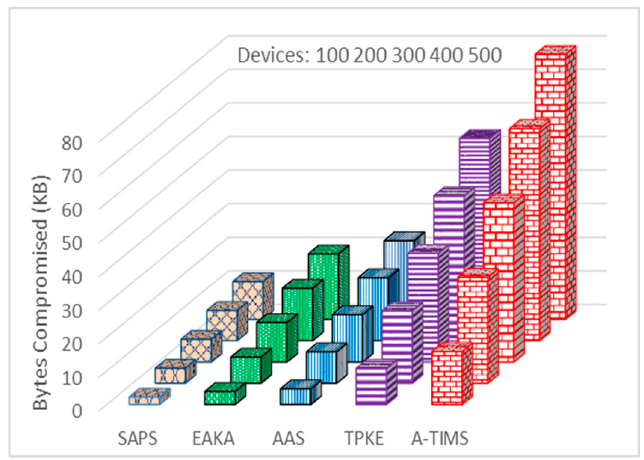
Figure 9. Bytes revealed upon device compromise.